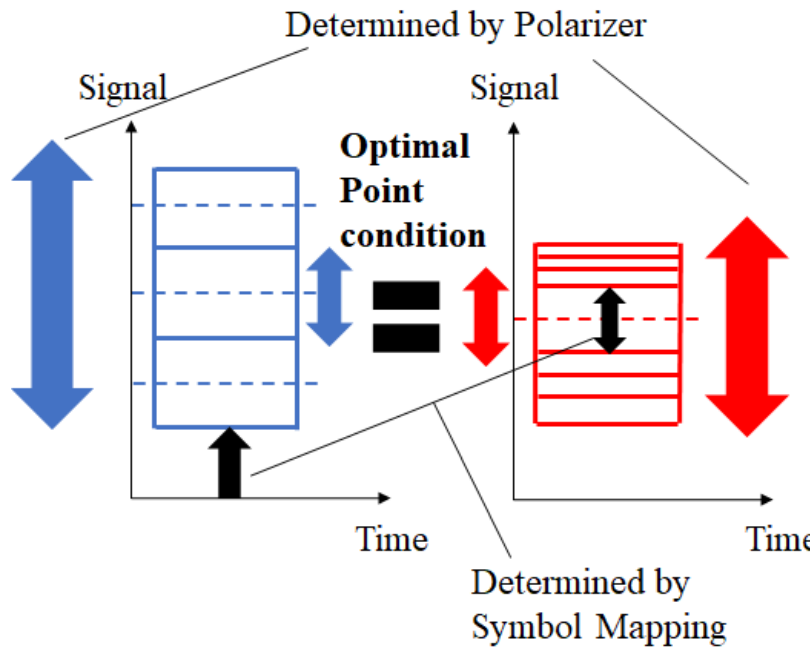
Figure 4. The optimal point condition of the proposed technique.